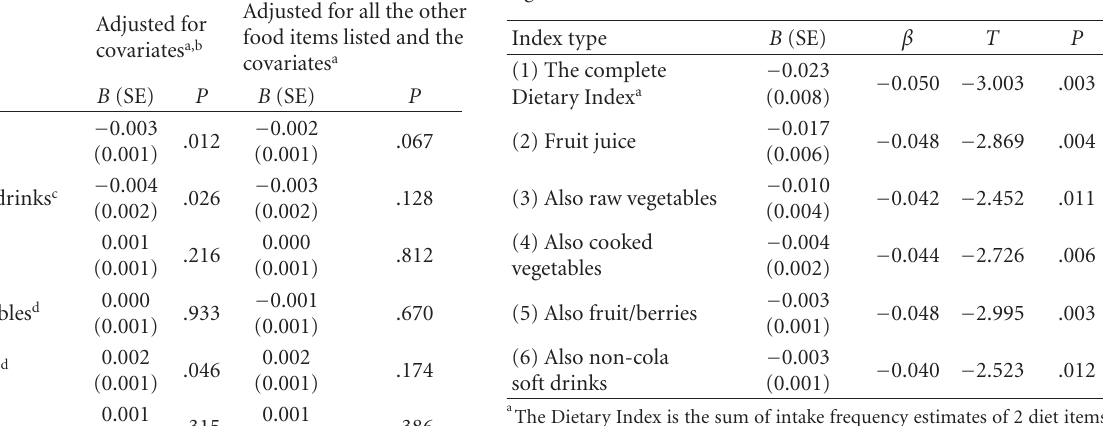
Table 4: Association between various indexes assumed to partially reflect the acid load and distal forearm bone mineral density. The index was reduced by omitting one by one of its components: linear